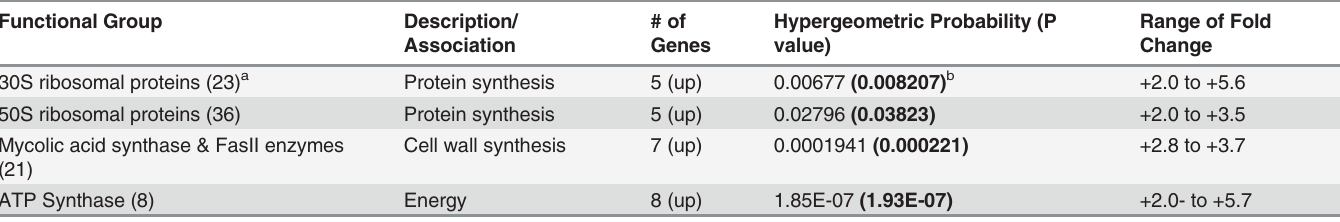
Table 4. Differentially expressed functional categories indicative of M . tb replication in type II AEC. Functional